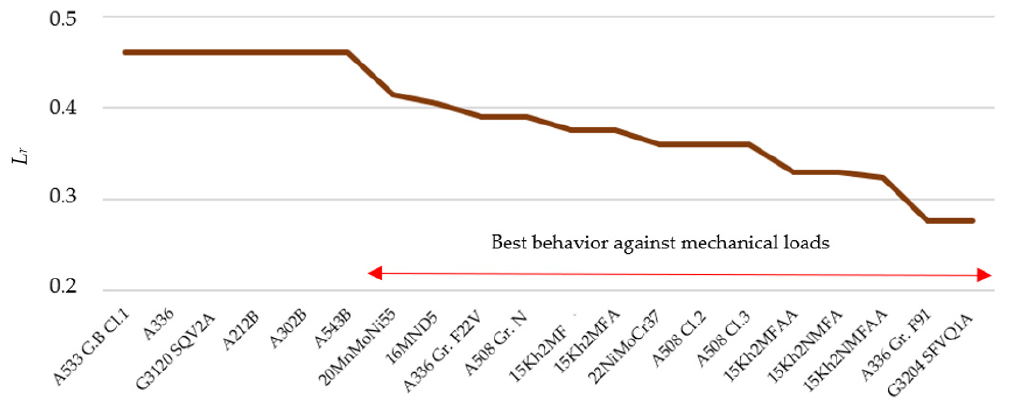
Figure 5 exhibits L r for each material analyzed.